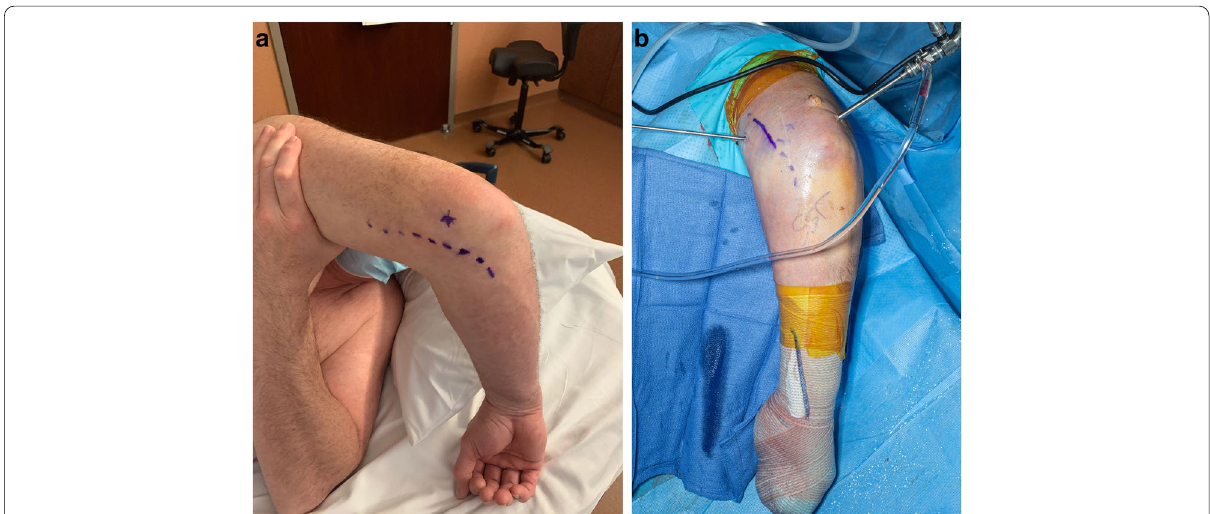
Fig. 5 Ultrasound tracing of the course of a transposed ulnar nerve may allow safe arthroscopic osteocapsular arthroplasty. A Marking of the ulnar nerve course prior to arthroscopy. B Arthroscopic portals avoiding the location of the previously transposed ulnar